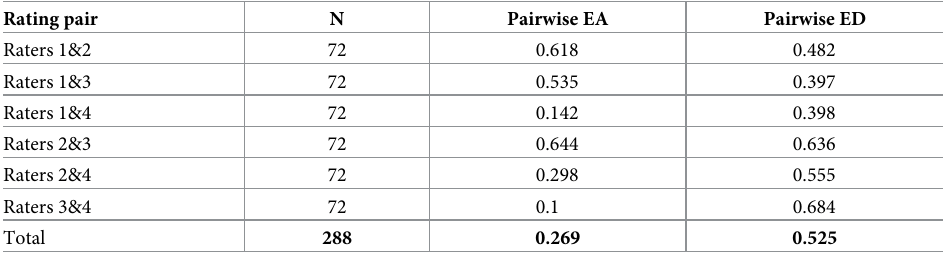
Table 4. Proportion of Cohen’s kappa pairwise agreement/disagreement between rating pairs utilizing the updated RUCAM scale.